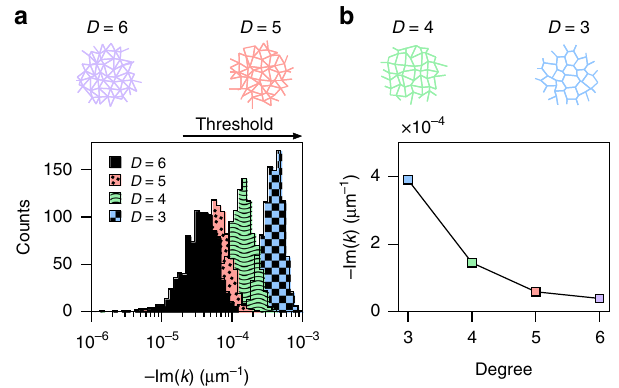
Fig. 4 Degree and threshold relation from model. a Threshold ( − Im( k )) distributions for networks with average degree D = 3,4,5,6 and constant number and density of nodes ( N = 600). b The lowest lasing threshold estimated from the model (averaged over 1000 different realisations) as a function of the average degree